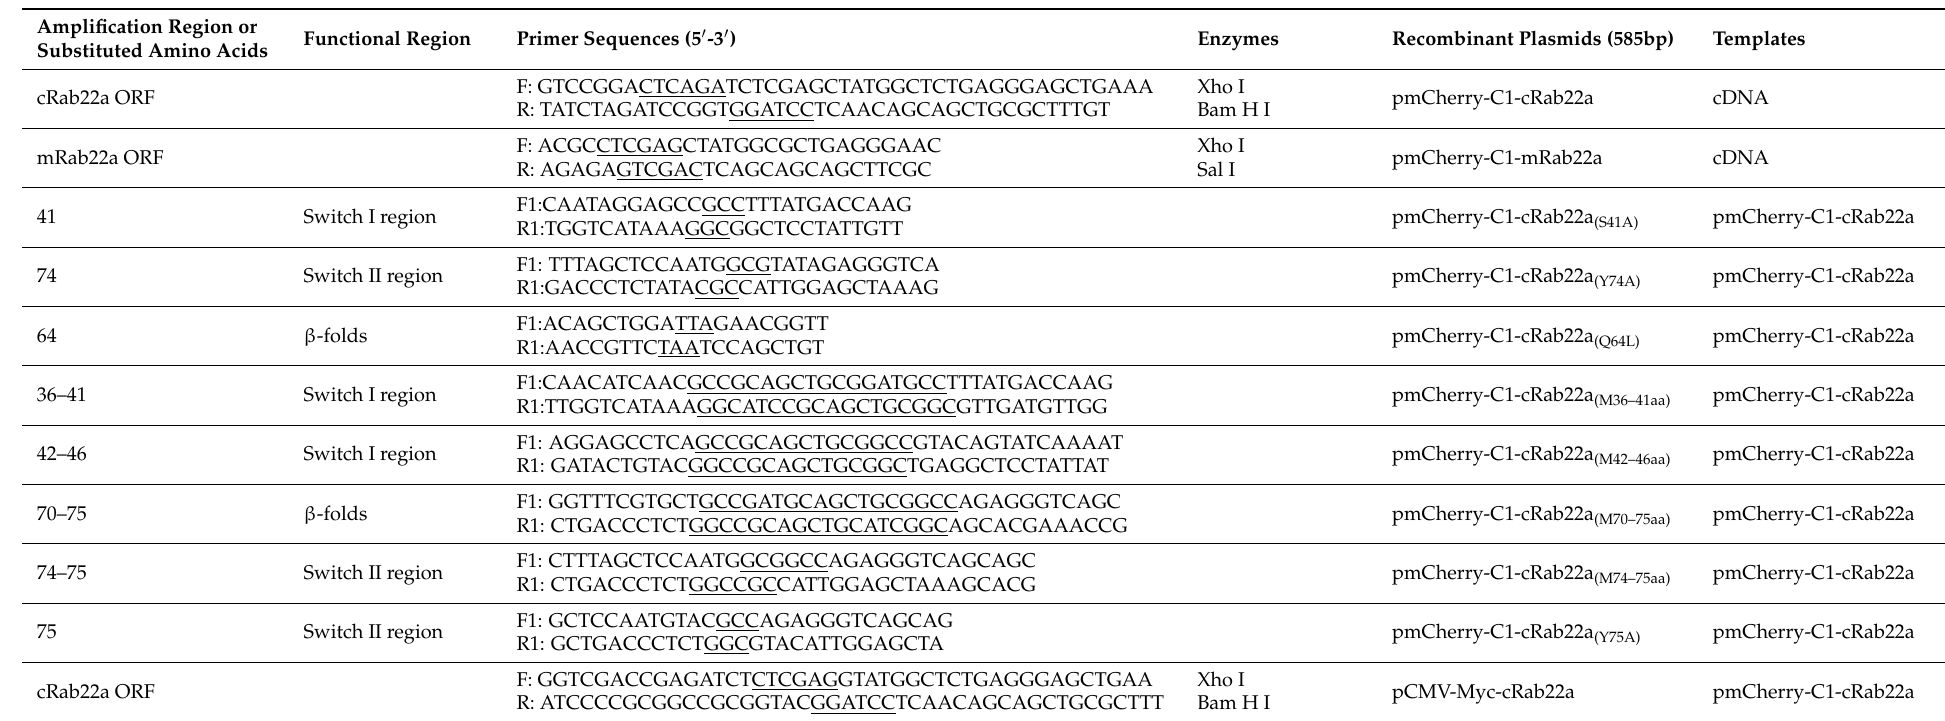
Table 1. Sequences of primers used in this